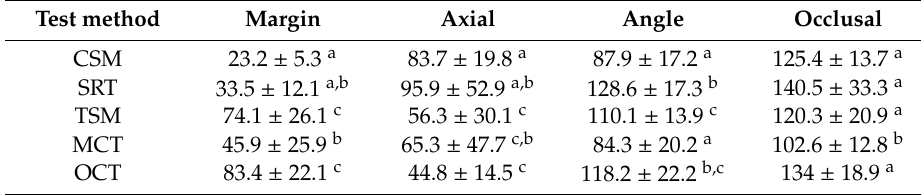
Figure 9. Result of the fitness measurement according to the measurement type and measurement region. Different superscript letters ( a – c ) indicate a statistically significant difference between the measurement types based on the Mann–Whitney U-test and Bonferroni correction method ( p < 0.005). Table 1. The marginal and internal gap of the cross-sectional method (CSM), silicone replica technique (SRT), triple scan method (TSM), micro-computed tomography (MCT), and optical coherence tomography (OCT). Gap values are depicted as mean (µm) ± standard deviation (SD).